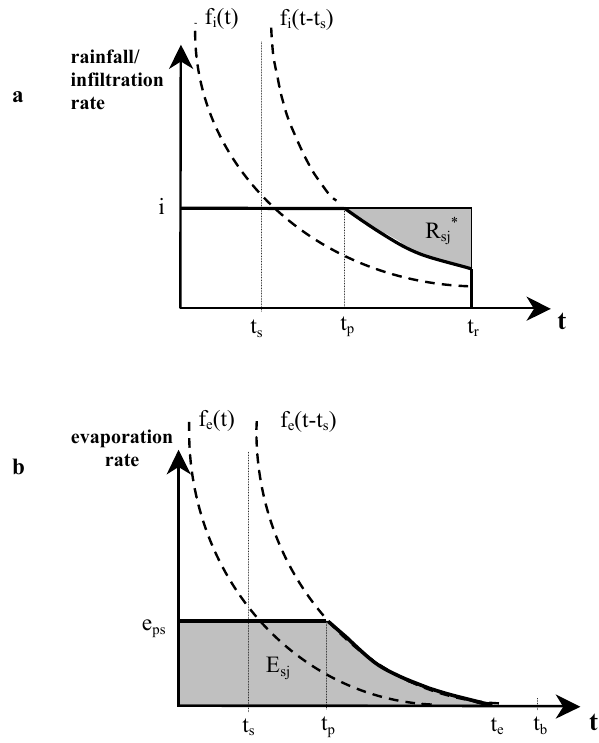
Fig. 3. The dynamics of: (a) infiltration, and (b) evaporation from the soil